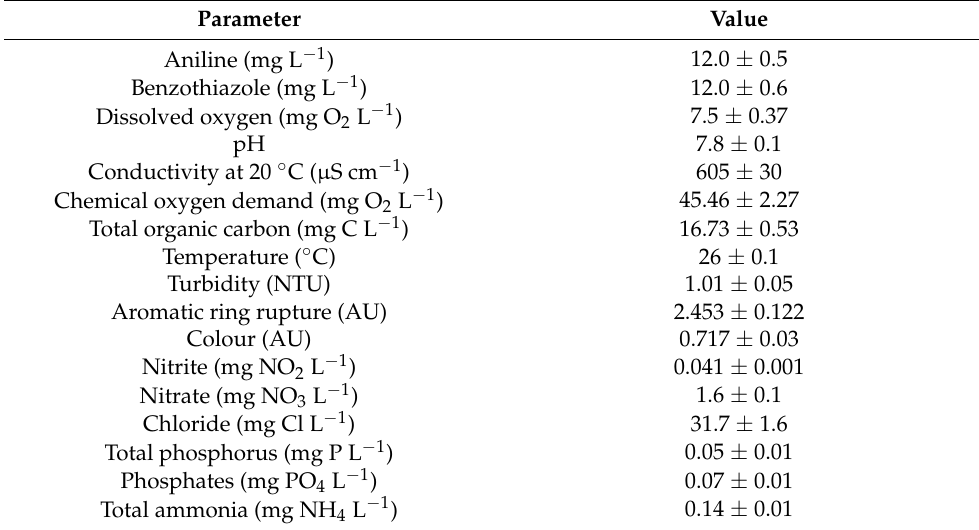
Table 1. Average physical–chemical profile of the industrial effluent containing ANI and BTH.